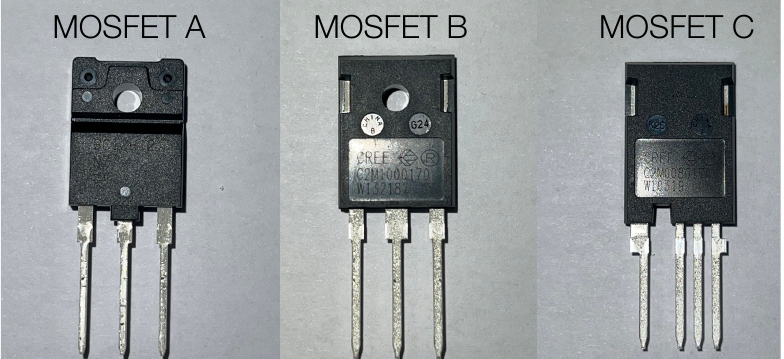
Figure 2. SiC-MOSFETs employed in this